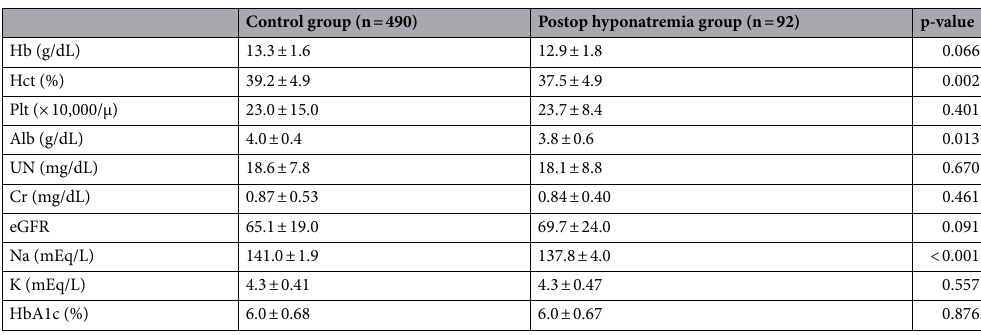
Table 3. Preoperative laboratory data. p-values were determined by the Mann–Whitney U test. Variables were represented by average ± 1.0 standard deviation. Alb albumin, Cre creatinine, eGFR estimated glomerular filtration rate, Hb hemoglobin, HbA1c hemoglobin A1c, Hct hematocrit, K potassium, Na sodium, Plt platelet, Postop postoperative, UN urea nitrogen.